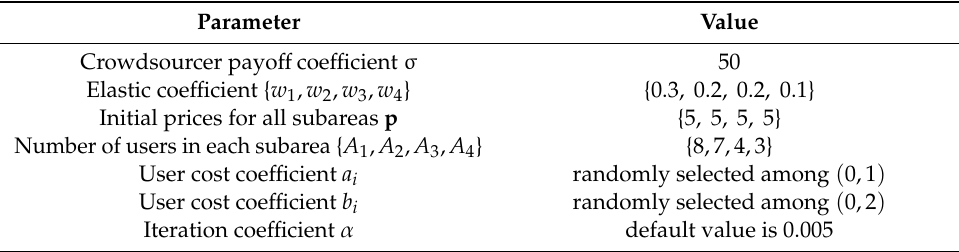
Table 1. Simulation